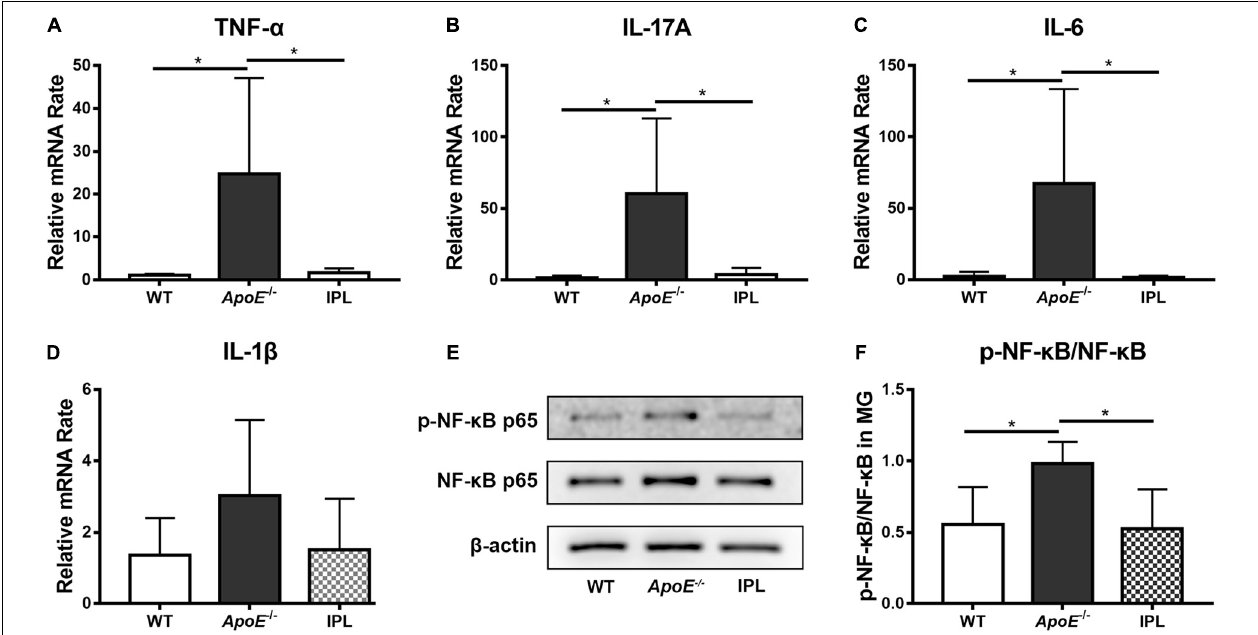
FIGURE 4 | Effects of IPL treatment on inflammation in MGs. (A–D) The relative mRNA levels of TNF- α , IL-17A, IL-6, and IL-1 β ( n = 5–6/group). (E) Western blot result of p-NF- κ B p65 and NF- κ B p65. (F) Relative p-NF- κ B p65 expression ( n = 4/group) in MGs. * p <